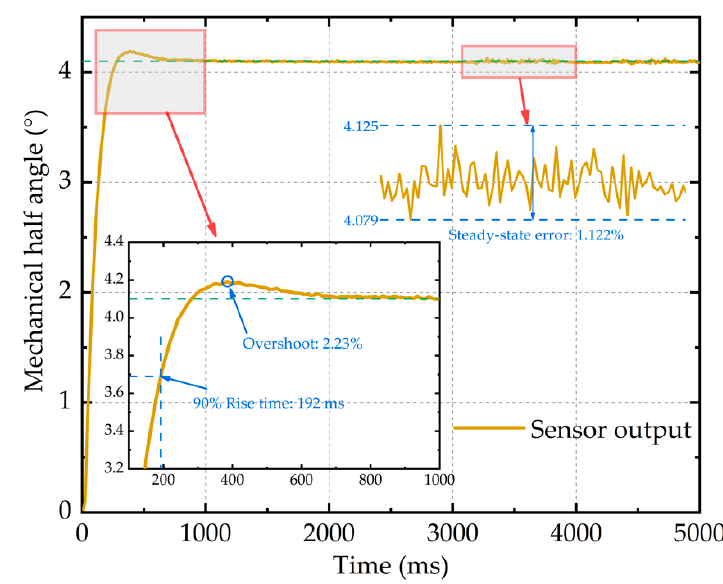
Figure 9. Step response test for the scanning micrograting in the open-loop state. The target of the mechanical half angle is set to 4.1°.